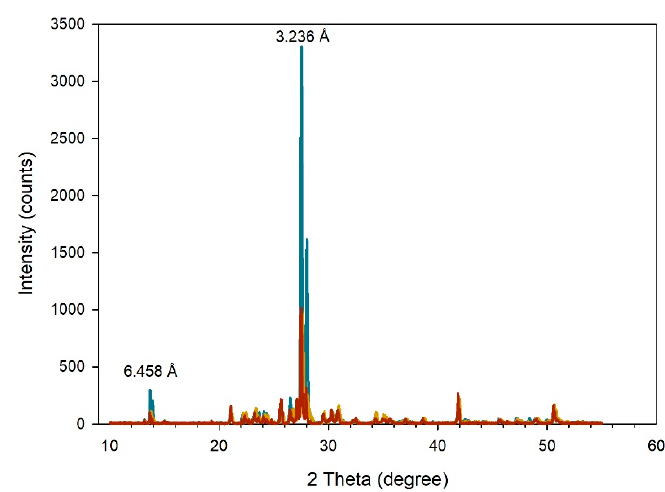
Figure 1. X-ray di ff raction (XRD) patterns of microcline particles smaller than 71 µ m (orange). XRD Figure 1. X-ray diffraction (XRD) patterns of microcline particles smaller than 71 μ m (orange). XRD patterns of microcline particles in the size range from 71 µ m up to 315 µ m (blue). XRD patterns of patterns of microcline particles in the size range from 71 μ m up to 315 μ m (blue). XRD patterns of reference microcline mineral, RRUFF ID: R040154 (red). reference microcline mineral, RRUFF ID: R040154 (red).